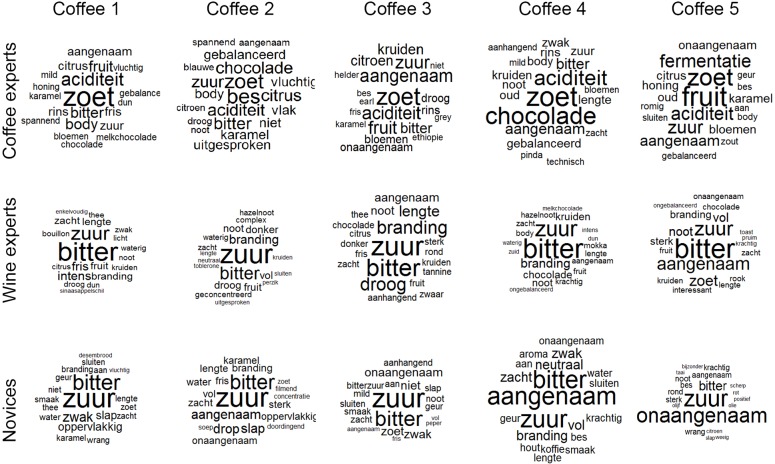
Word clouds of the 20 most frequent terms for coffee flavors.Wine experts and novices agreed more in their descriptions and predominantly describing all coffees as bitter and sour. Coffee experts, on the other hand, gave distinct flavor profiles to each coffee.